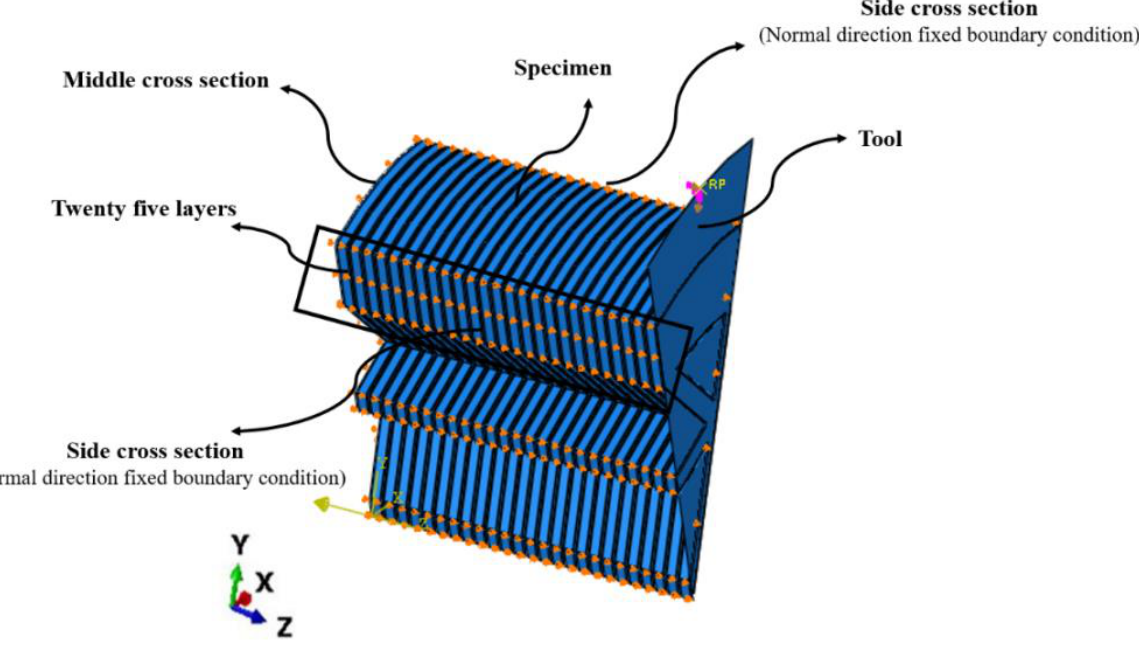
Figure 6. Three-dimensional model of the MEX-produced specimen (geometrical simplified model).